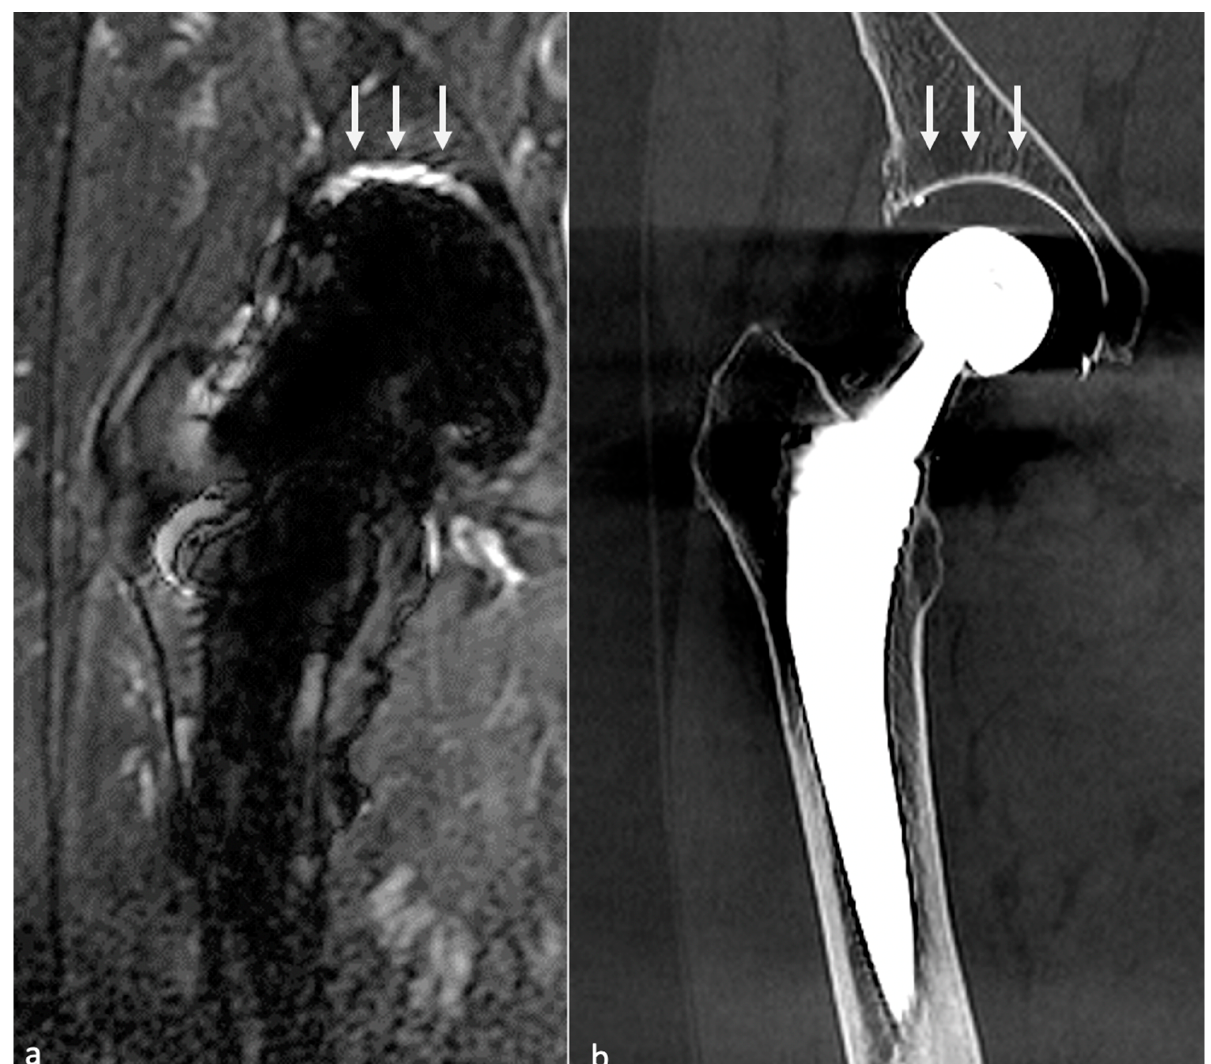
Figure 14. Acetabular fibrous membrane. A thin STIR hyperintense layer (white arrows) is shown close to the acetabular piece on ( a ) a frontal STIR image, without osteolysis in the corresponding zone on ( b ) a coronal CT ‐ scan slice.